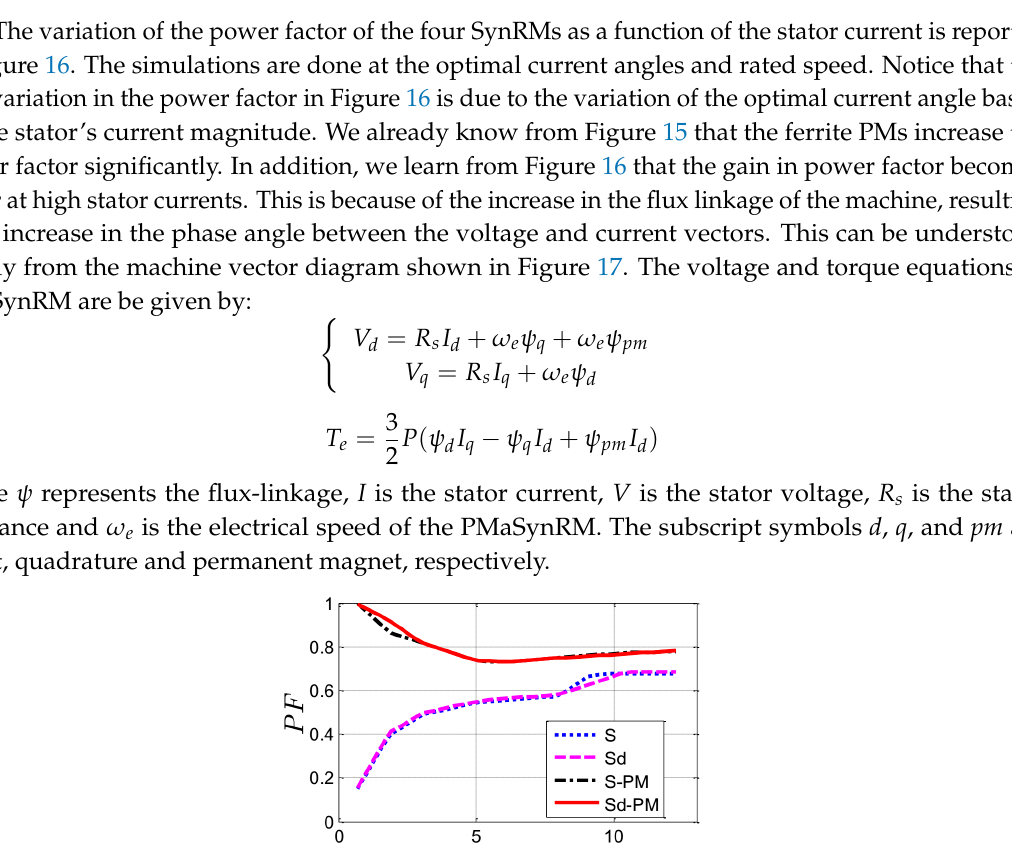
Figure 15. SynRM power factor ( PF ) as a function of current angle ( α ) at rated current and speed.